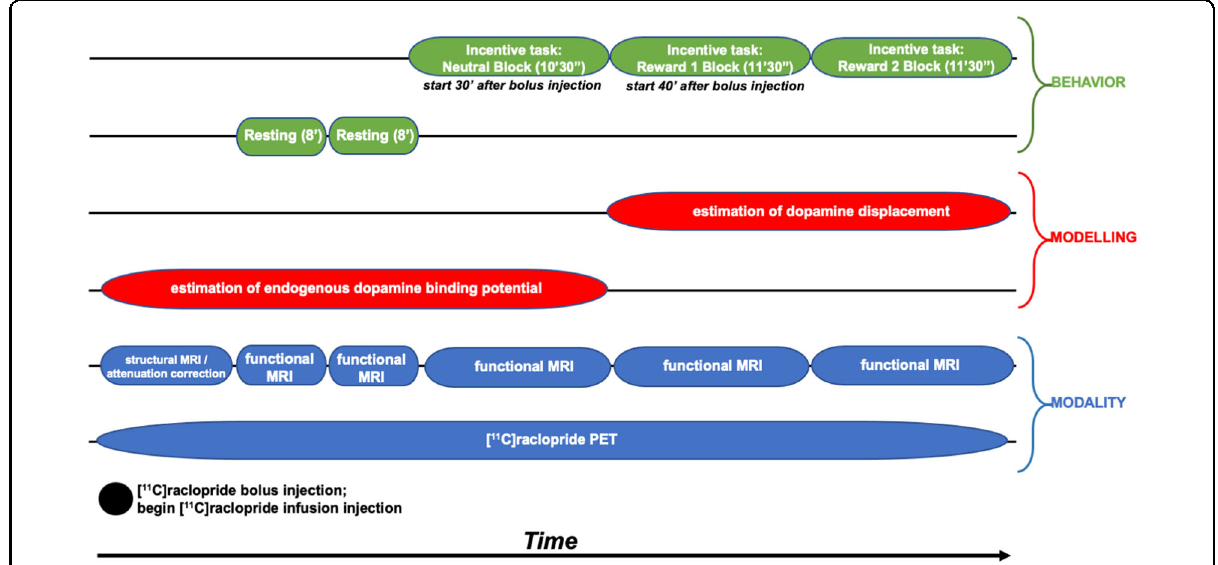
Fig. 1 Timing of data collection, data modeling, and participant behavior during scanning. Three task blocks were presented during which fMRI data were collected simultaneously to the PET